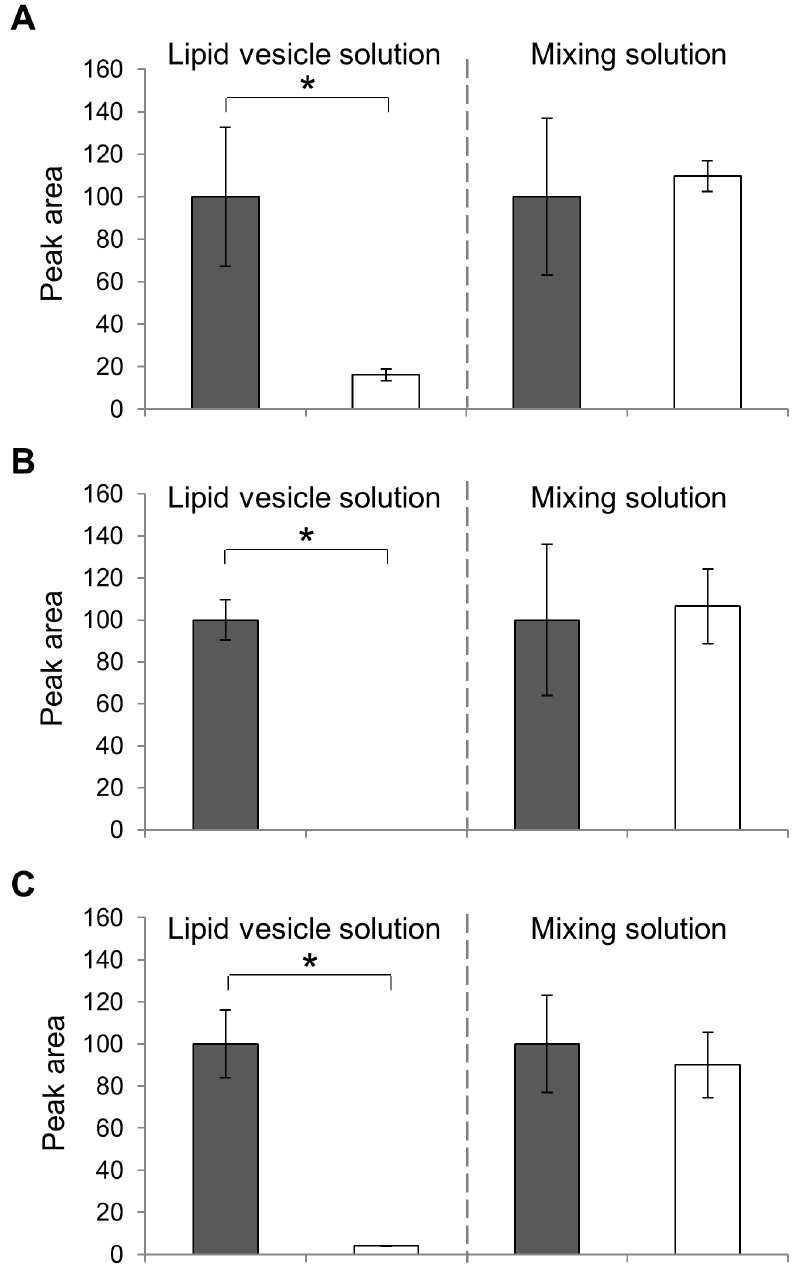
Figure 7. GC / MS spectrometry of IA ( A ), IAA ( B ), and CA ( C ) vesicles. The peak area of the pre-filtered (gray bars) and its filtered solution (white) solution of the lipid vesicle solution (left bar graph) and the mixed solutions (right) are compared. The peak values are calculated as a percentage of the pre-filtered solution (100%). Each bar represents the average value of three samples; standard errors are shown as error bars. (* p < 0.05).